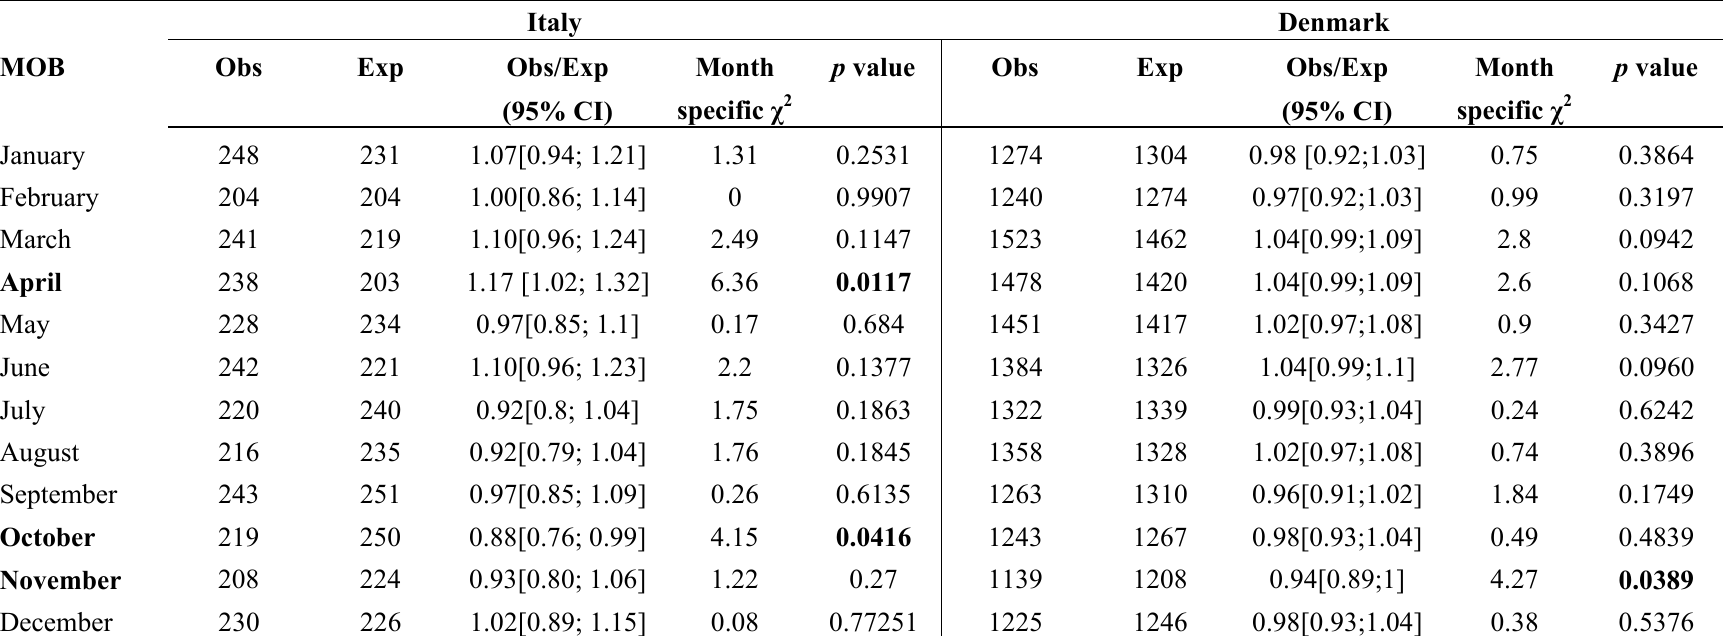
Table 2. Seasonality overall results for Italy and Denmark normalized for the specific general population data. Italy